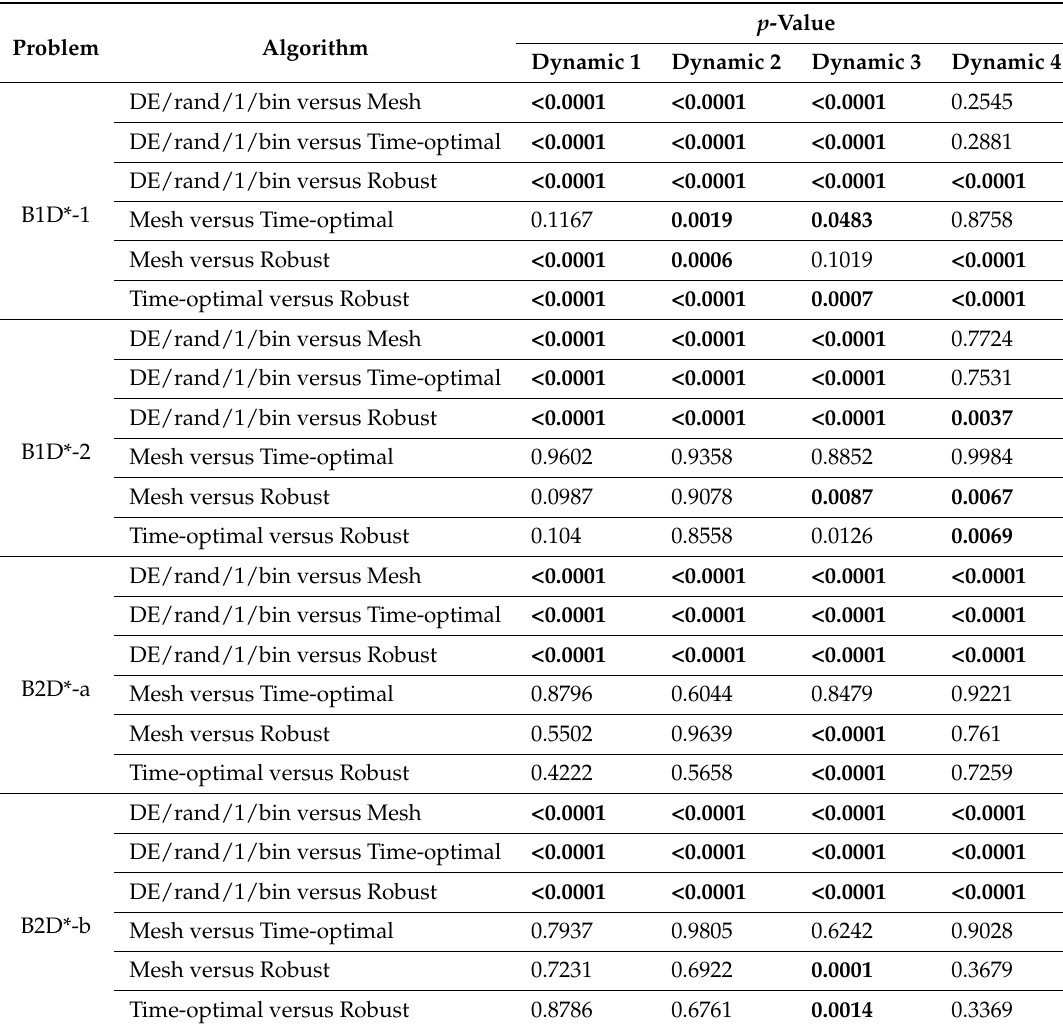
Table 6. Results of the 95%-confidence Wilcoxon signed-rank test. A p -value less than 0.05 means that exists significant